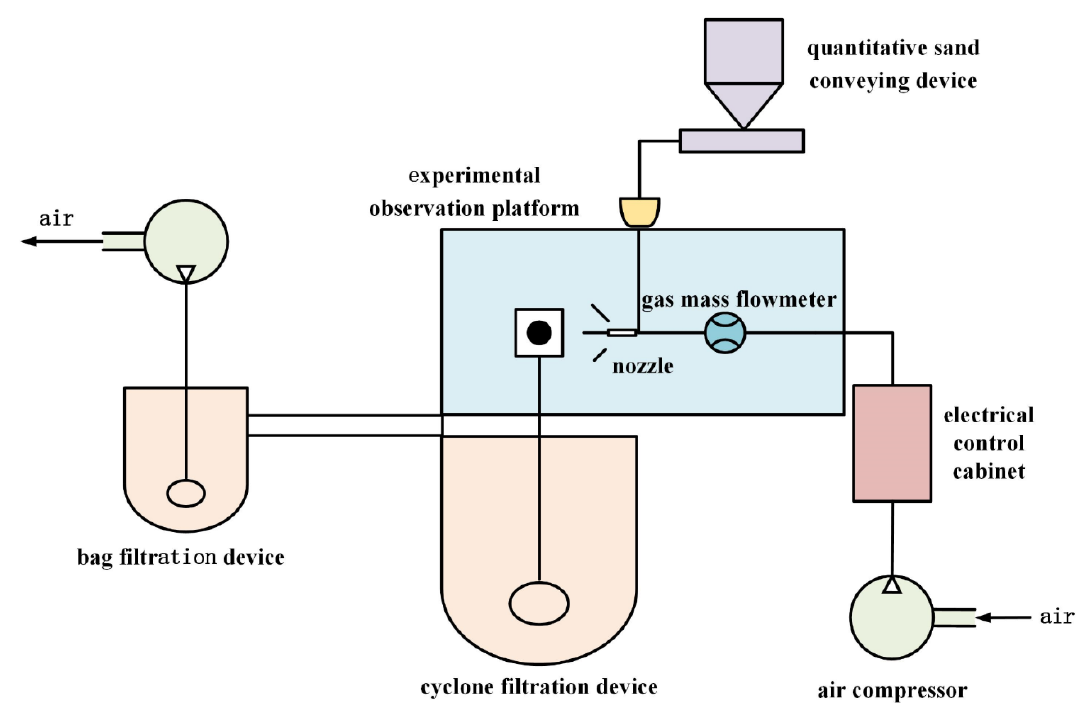
Figure 1. Partial diagram of the gas-solid two-phase flow erosion test device, nozzle, and specimen.